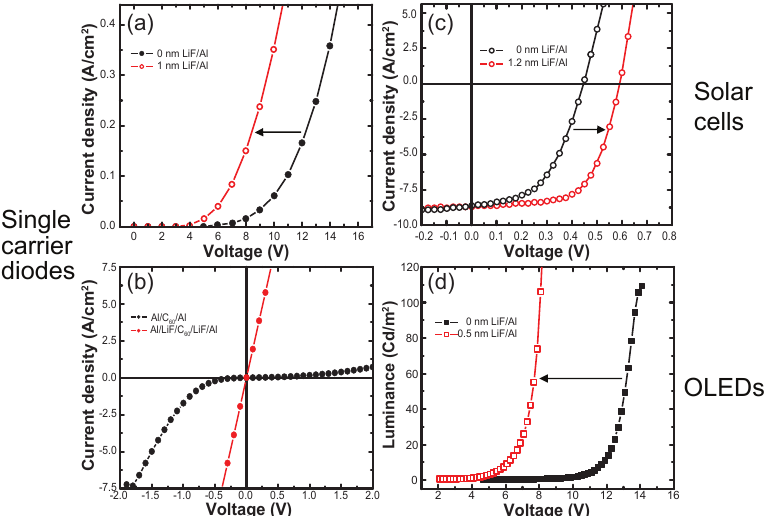
Figure 1. ( a ) Impact of a thin LiF layer (1.0 nm) between cathode metal and electron transport material on the current–voltage, I–V, characteristics for Alq 3 (65 nm). Insertion of LiF between aluminum and Alq 3 significantly enhances the injection current. Adapted from Ref. [83] copyright (2000) with permission from Elsevier. ( b ) I–V characteristics of Al/C 60 /Al devices with and with- out LiF interlayer 0.5 nm. The bias was applied to the bottom electrode in reference to the top grounding electrode. Adapted from Ref. [84] with the permission of AIP Publishing. ( c ) Typical illuminated current density–voltage, J–V, curves for photovoltaic cells with the inclusion of a LiF layer. Adapted from Ref. [85] with the permission of AIP Publishing. ( d ) Luminance–voltage (L–V) characteristics of multilayer OLED device with Alq 3 electron transporting layer. Device structure glass/ITO/NPB(60 nm)/Alq(25 nm)/LiF (0 or 0.5 nm)/Al(150